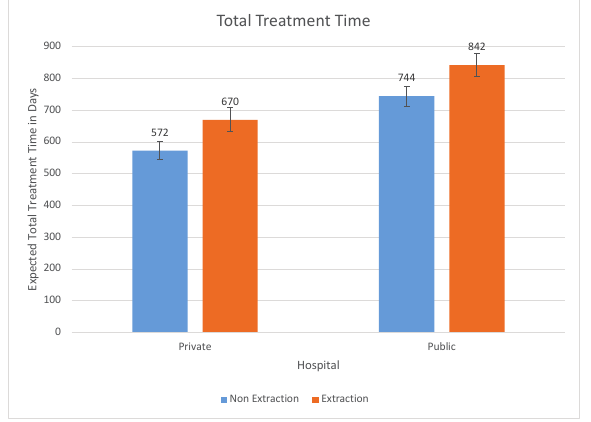
Figure 5. Total treatment time in private compared to public environment dependent on extraction or non-extraction treatment.